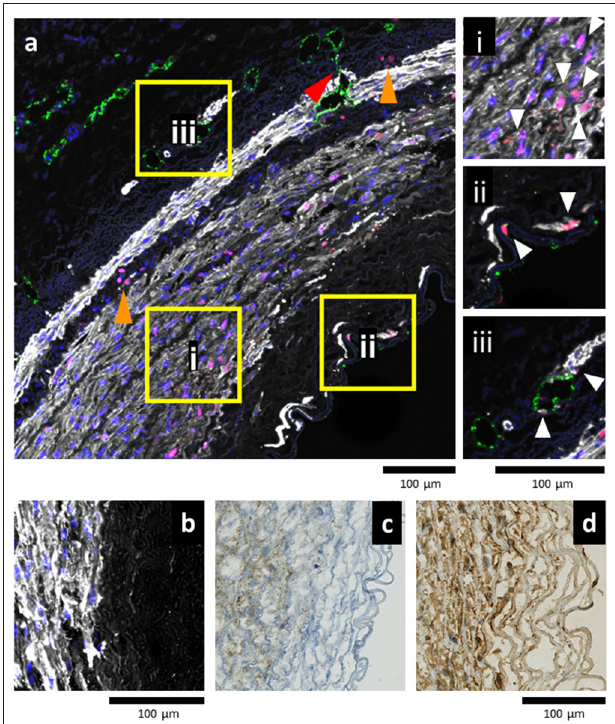
FIGURE 7 | Balloon angioplasty stimulates early remodeling in EasyFlow cultured arteries. Representative confocal images of the arterial wall following injury and flow culture (a) reveals proliferation (proliferating cell nuclear antigen, PCNA, magenta) of smooth muscle cells (smooth muscle actin, SMA, white) in the proximity of the injured media (ai) . In the lumen area, individual proliferating (PCNA + ) smooth muscle cells (SMA + ) and endothelial cells (CD31 + , green) are located either side of the lamina elastica (aii) . In the adventitia, proliferative endothelial cells (CD31 + ) line the microvasculature of the vasa vasorum (aiii) . White arrowheads indicate proliferative cells. Across the vessel wall, groups of infiltrating cells display PCNA + nuclei (orange arrowheads), and small blood vessels sprout from the adventitia toward the media (red arrowhead). Nuclei are stained with DAPI, Scale bar = 100 µ m. Smooth muscle cells near the injury area display high expression levels of SMA white (b) , Vimentin (c) , and PDGFR β (d) . Scale bars = 100 µ